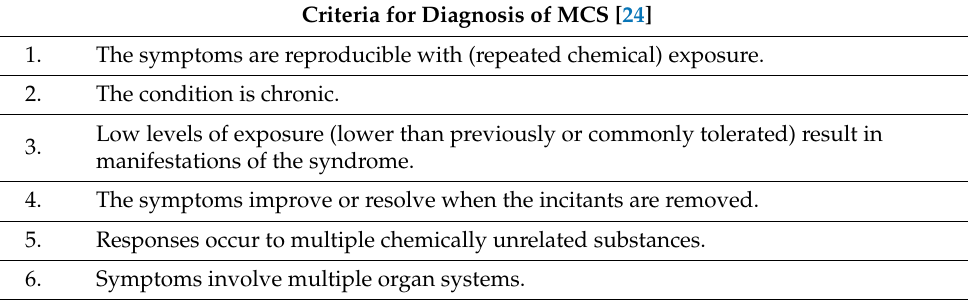
Table 1. Consensus criteria for the diagnosis of